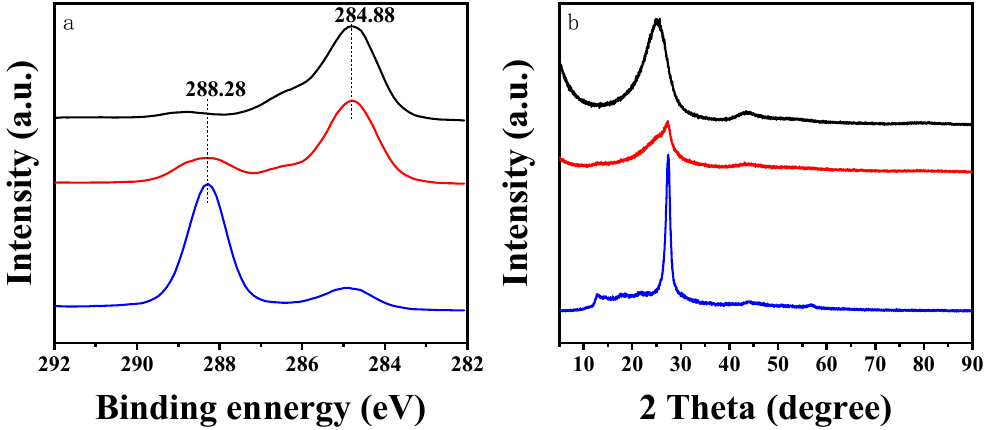
Figure 2. The XPS C1s spectra and the XRD profiles of the CF, g-C 3 N 4 , and g-C 3 N 4 /CF (CF: black line, g-C 3 N 4 /CF: red line, g-C 3 N 4 : blue line). ( a )The XPS C1s spectra of CF, g-C 3 N 4 , and g-C 3 N 4 /CF. ( b ) The XRD profiles of CF, g-C 3 N 4 , and g-C 3 N 4 /CF.